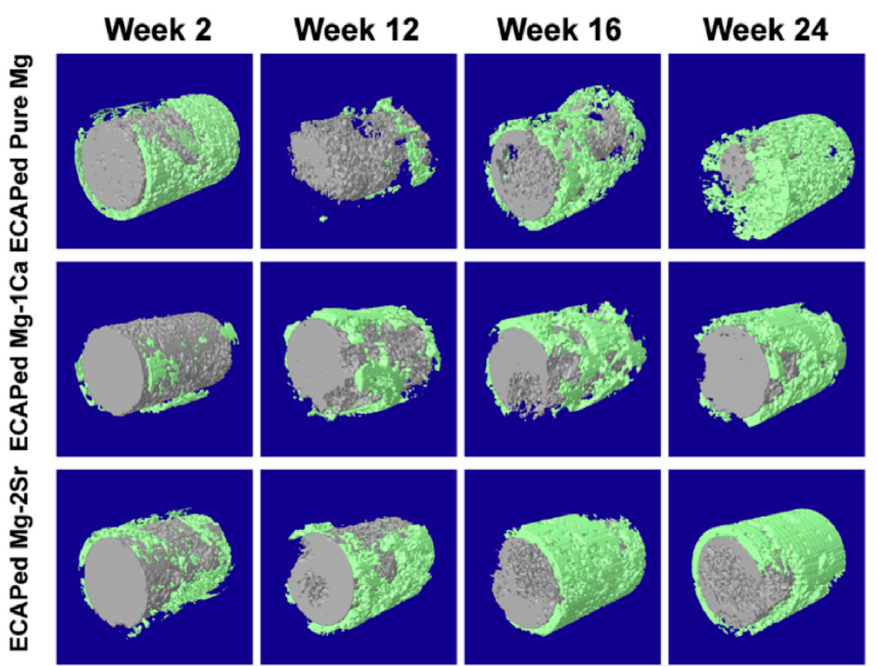
Figure 11. Micro-CT 3D reconstruction of implants (gray in color) of Mg, Mg–1%Ca and Mg–2%Sr processed via ECAP and bone around the implant (green in color) after 2, 4, 16 and 24 weeks of in vivo degradation [58]. Table 3. Summary of in vivo tests carried out in Mg and Mg alloys processed via SPD.